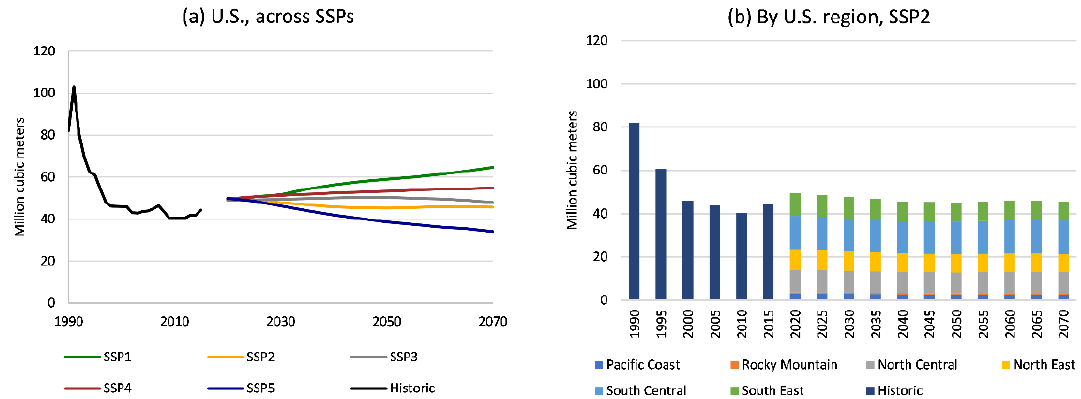
Figure 12. United States production of fuelwood ( a ) across SSPs and ( b ) by region within SSP2, 1990 to 2015 historic, 2020 to 2070 projections from FOROM.